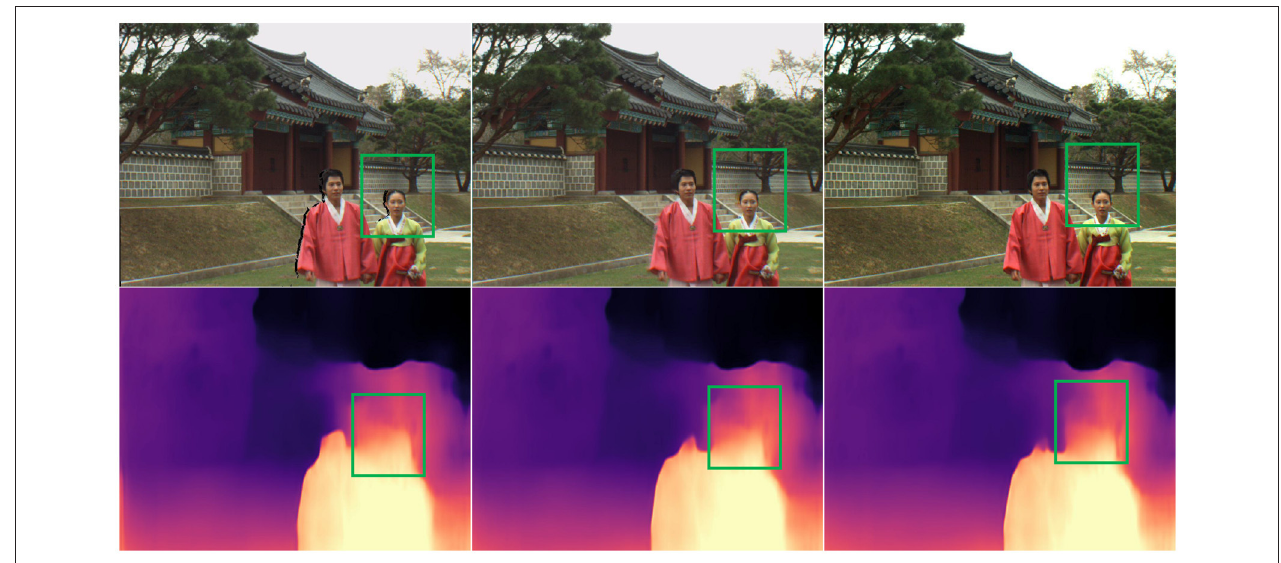
FIGURE 4 | Examples of the depth maps of two synthesized images and their reference image. From top to bottom, the images in each column are a synthesized/reference image and its corresponding depth map. Note that the synthesized image of the first column has only the warping